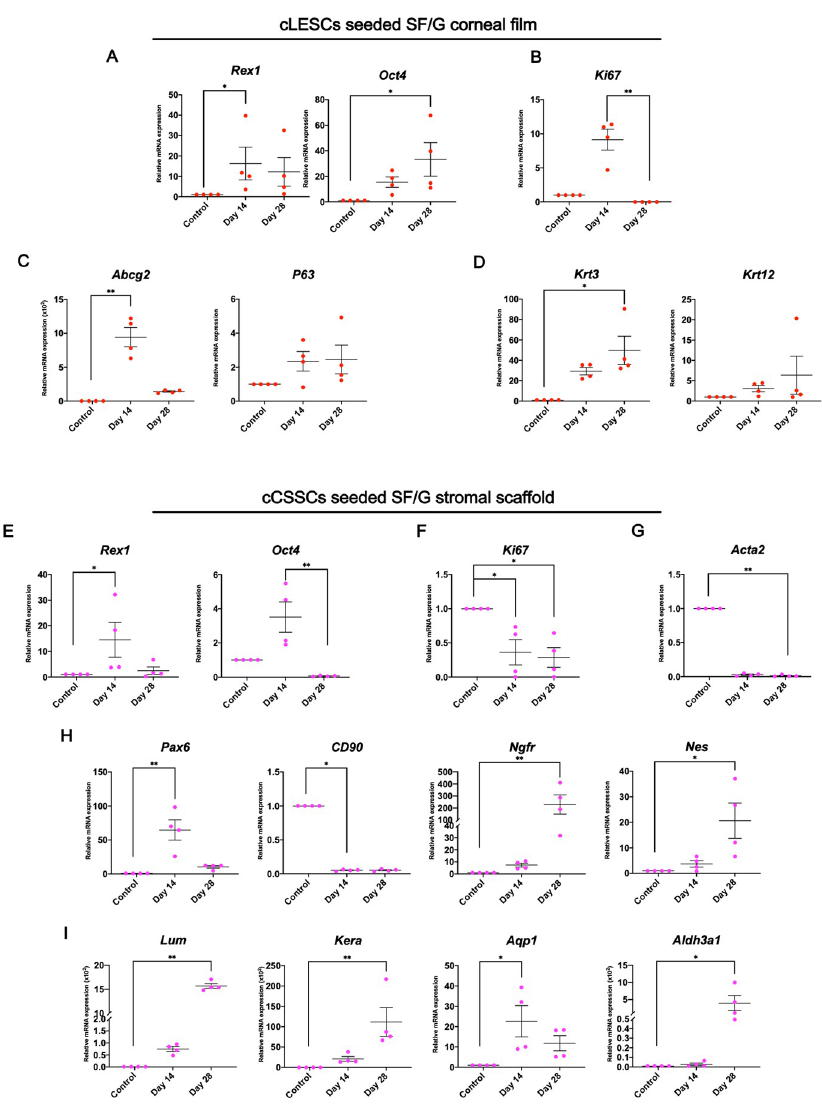
Fig 5. mRNA expression of cLESCs seeded SF/G corneal film and cCSSCs seeded SF/G stromal scaffold. Fold changes of RT-qPCR expression data of the control (cells culture on tissue culture plate for 14 days) and cLESCs seeded SF/G corneal film at 14 and 28 days are presented. cLESCs seeded SF/G corneal film at 14 and 28 days shows the upregulation of pluripotent (A), adult stemness-related markers (C), and epithelial cells markers (D) compared to the control. The proliferation marker shows upregulation at day 14 and downregulation at day 28 (B). RNA expression of pluripotent (E) and adult stemness-related markers (H) of cCSSCs seeded SF/G stromal scaffold reveals upregulation at day 14, except CD90 shows downregulation at day 14 and 28. The proliferation marker (F) and myofibroblast marker (G) are downregulated at both time points. Upregulation at day 14 and 28 of both time points is presented by the keratocyte marker (I). Values represent mean ± SEM, n = 4 ( � p < 0.05, �� p < 0.01).